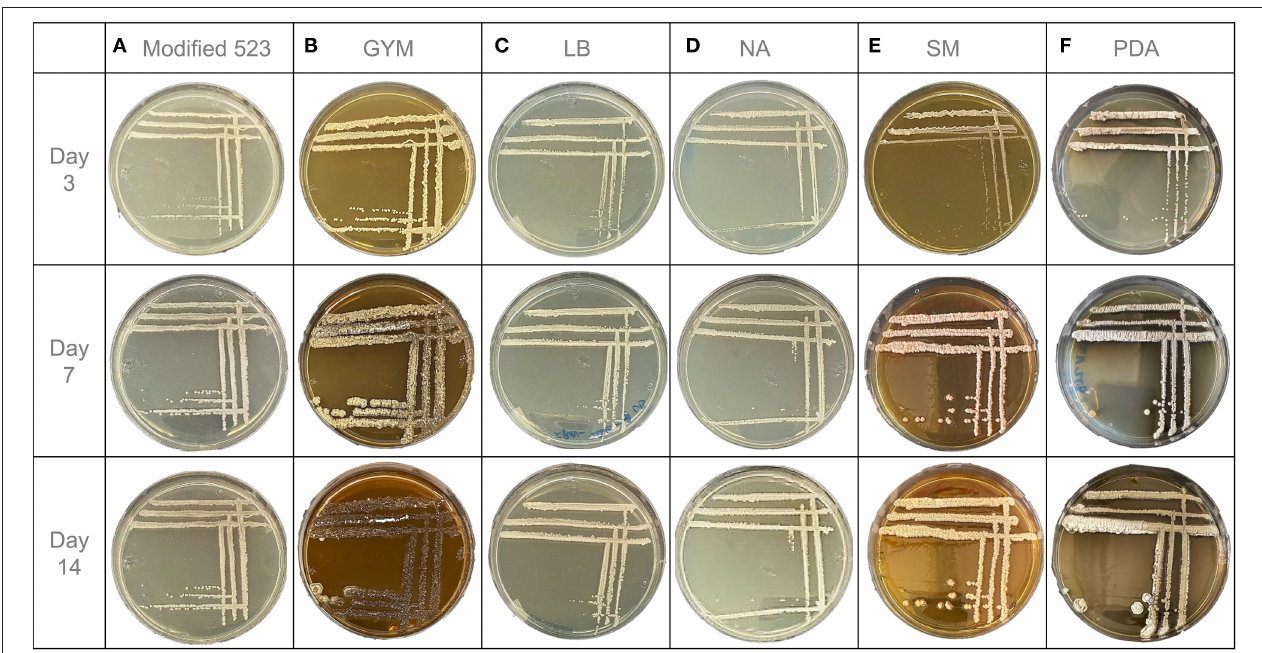
FIGURE 2 | OSMAC-assisted phenotypic characteristics of endophytic S. pulveraceus ES16 grown on six different agar media for 14 days. (A) Modified 523 medium. (B) Glucose Yeast Malt medium (GYM). (C) Lysogeny medium (LB). (D) Nutrient agar (NA). (E) Streptomyces medium (SM). (F) Potato dextrose agar (PDA).